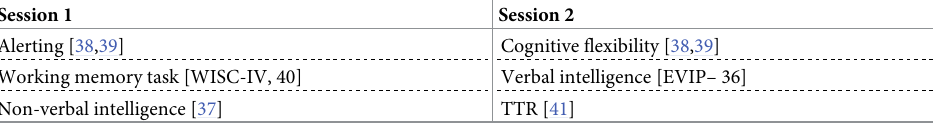
Table 3. Order of presentation and distribution of the tests by session.